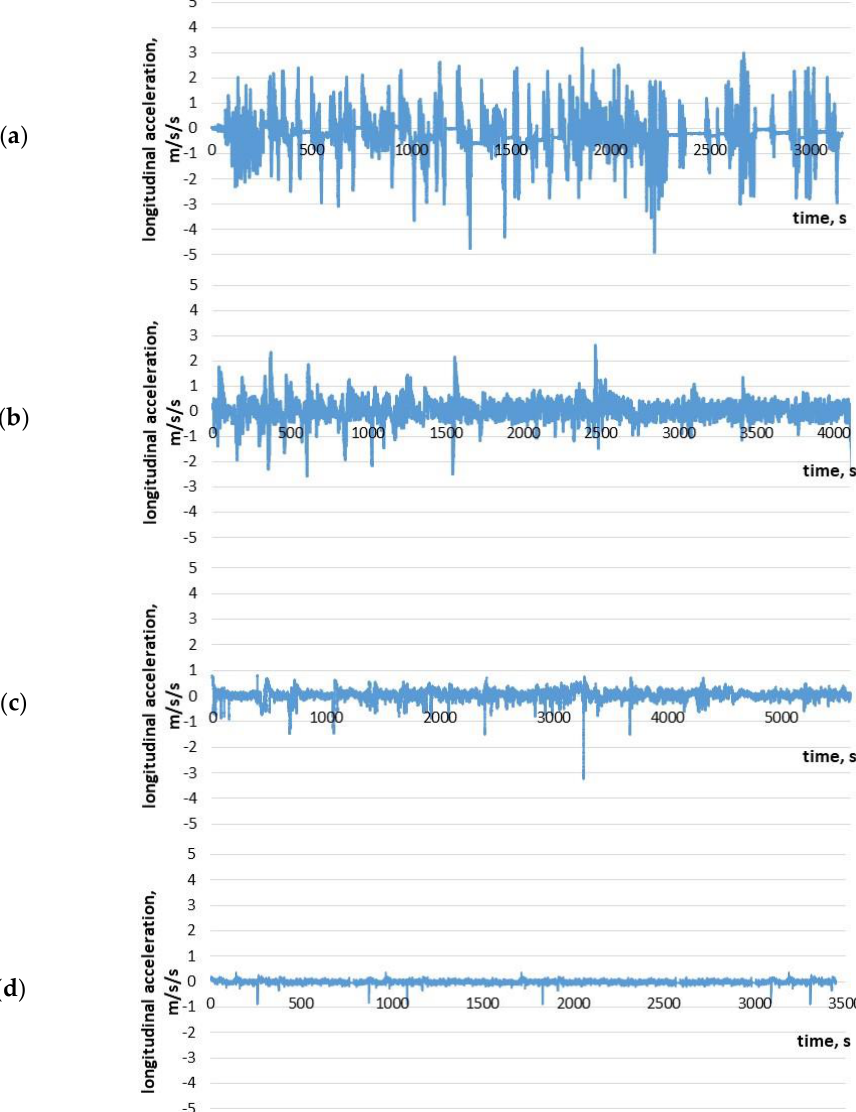
Figure 3. Values of longitudinal acceleration at specific sections on various road types: ( a ) urban area (city); ( b ) non-urban area (single roadway with two traffic lanes); ( c ) two-roadway expressway; ( d ) motorway. Table 1. Longitudinal acceleration at specific road